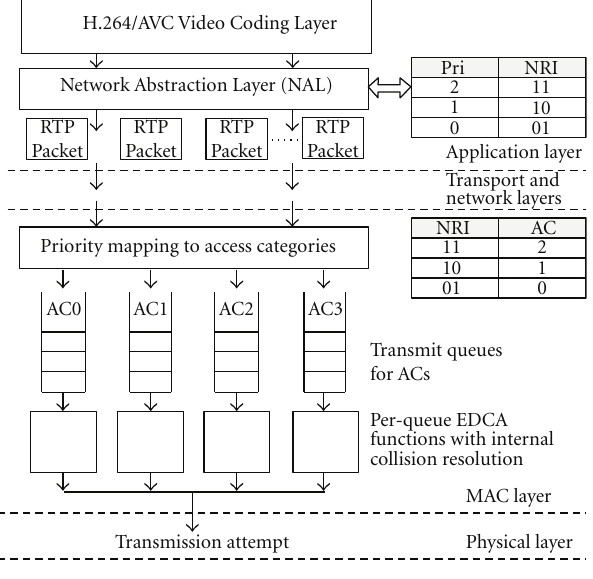
Figure 2: Cross-layer priority signalling to the IEEE 802.11e access